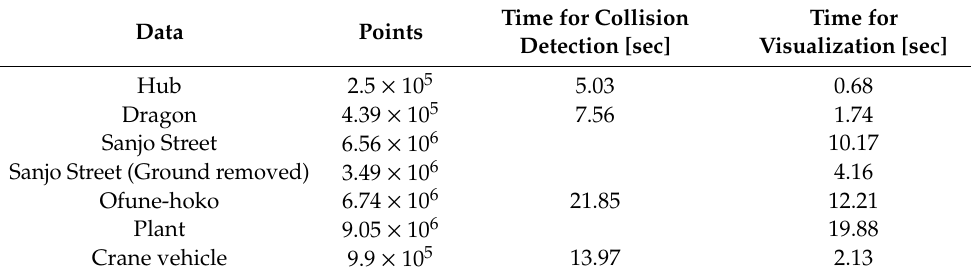
Figure 20. Density distribution result and the averaged volume density of crane vehicle. Table 1. The total number of points and the execution time for each experiment